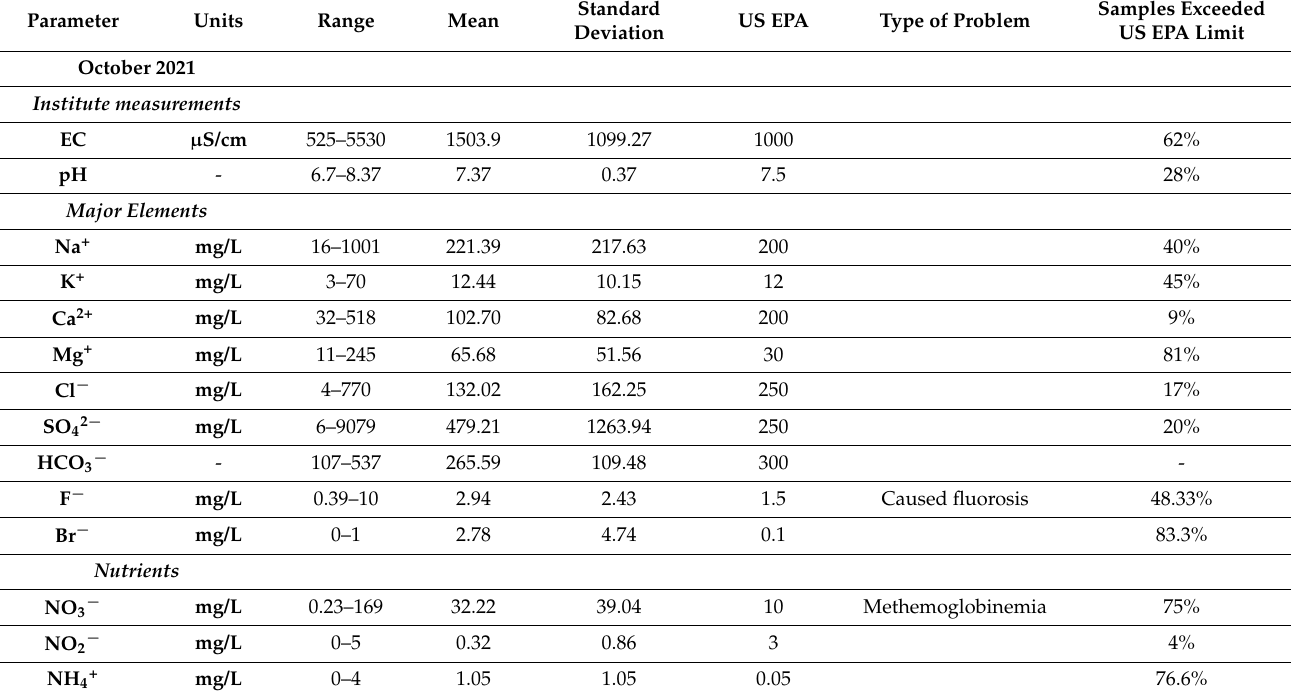
Table 2. Statistical analysis of the measured water parameters compared to US EPA standard